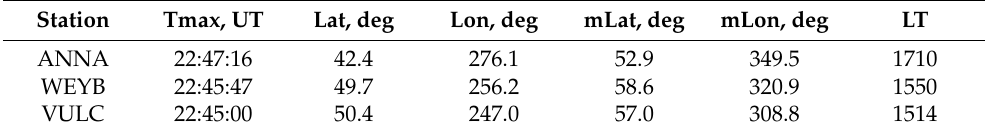
Table 1. Peak time of magnetic variations.